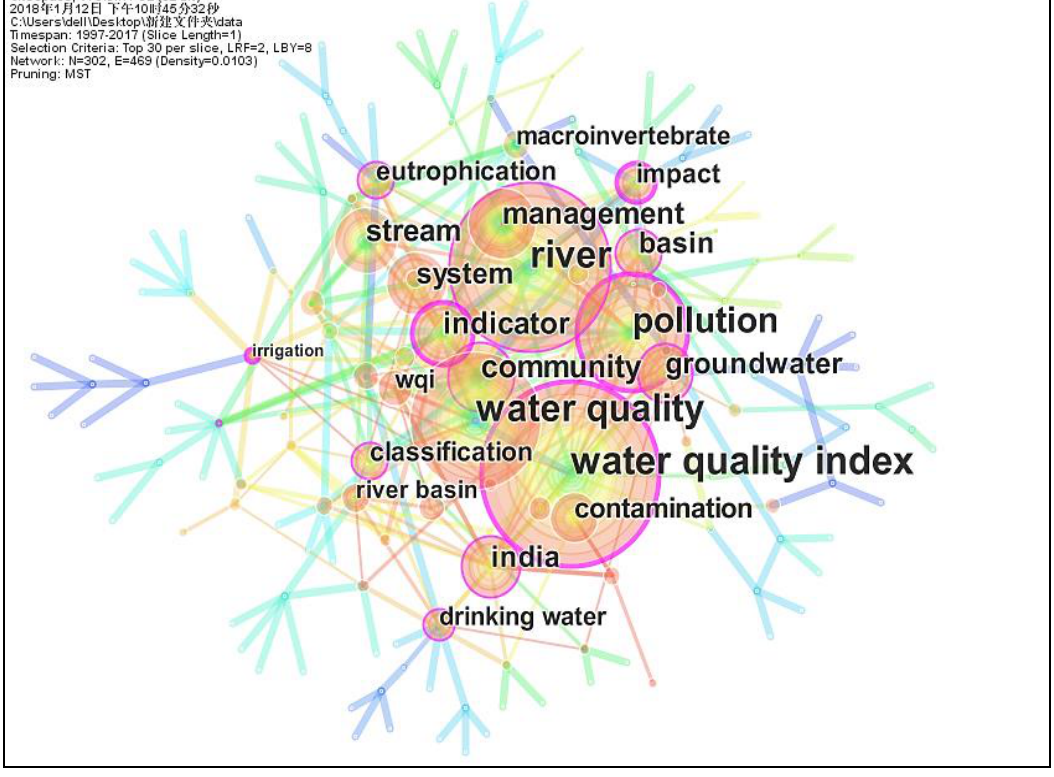
Figure 1. The information of WQI keyword co-occurrence